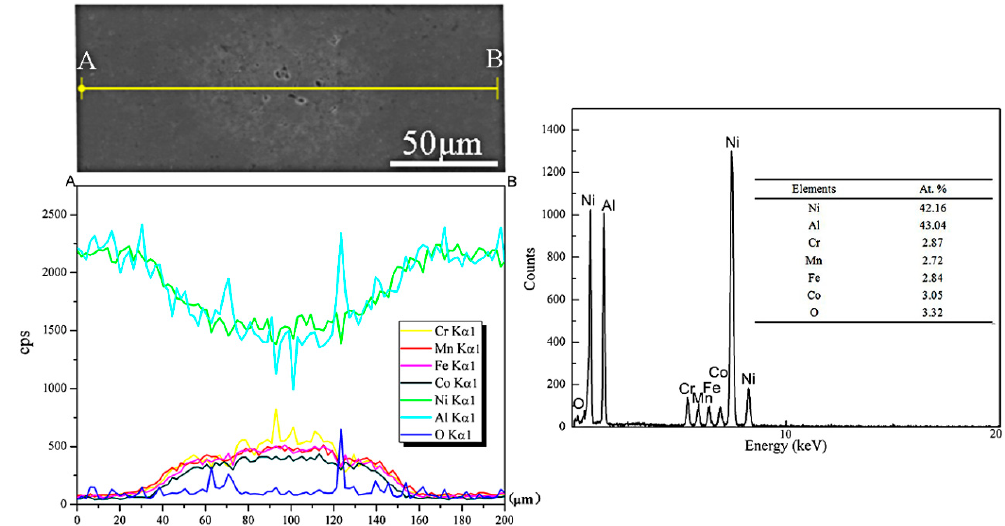
Figure 5. Energy dispersive spectroscopy (EDS) line analysis along line AB (10 wt.% HEA). Materials 2018 , 11 , x FOR PEER REVIEW